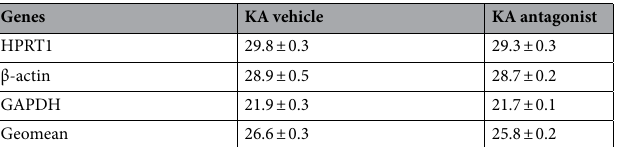
Table 1. CT values and geometric means of housekeeping genes from mice three days after SE. Data for are the mean ± SEM. (n=20 KA vehicle, n=19 KA